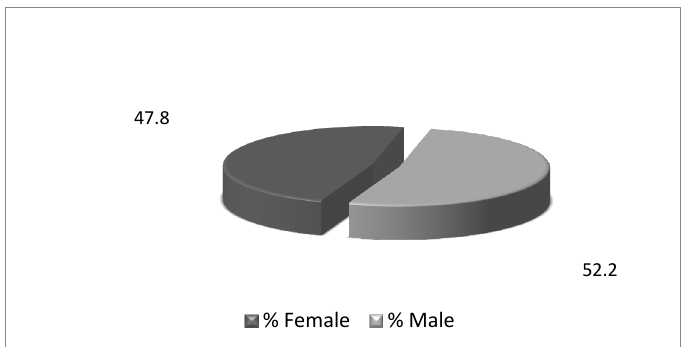
FIGURE 2: Gender distribution of respondents, 2008. Source: Survey data (2008)